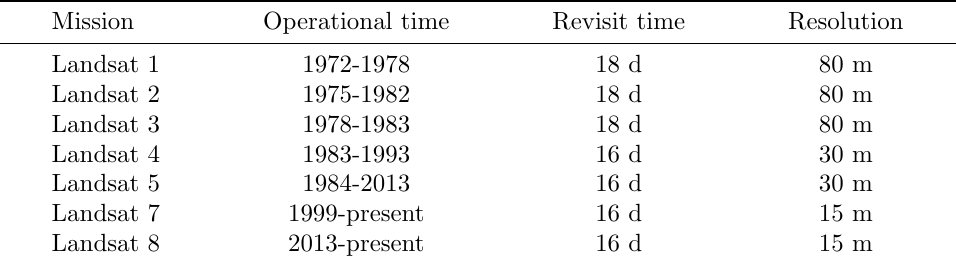
Table 1: Overview of Landsat missions, their revisit time and spatial resolution Mission